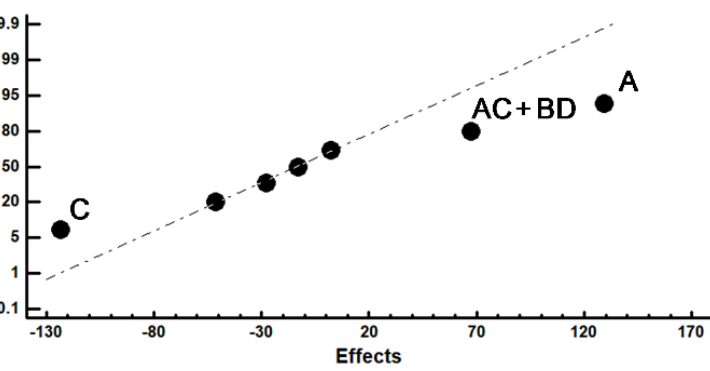
Figure 8. Analysis of interactions with a significant effect with respect to the hardness of the constituent matrix. X ‐ axis represents the two levels of A ‐ factor (figure (a)) and the two levels of B ‐ factor (figure (b)). Y ‐ axis represents the two levels of C ‐ factor (figure (a)) and the two levels of D ‐ factor (figure (b)). Z ‐ axis represents the effect of each possible combination: